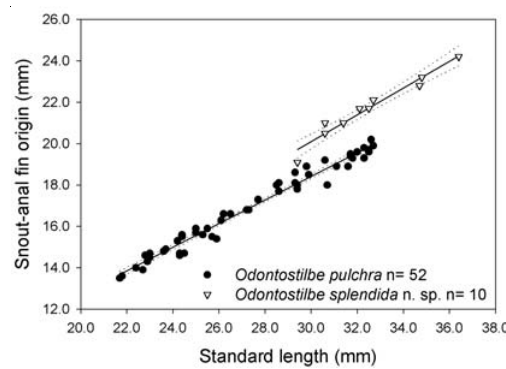
Fig. 17. Snout-anal fin origin as a function of standard length for males of Odontostilbe pulchra , against O. splendida .